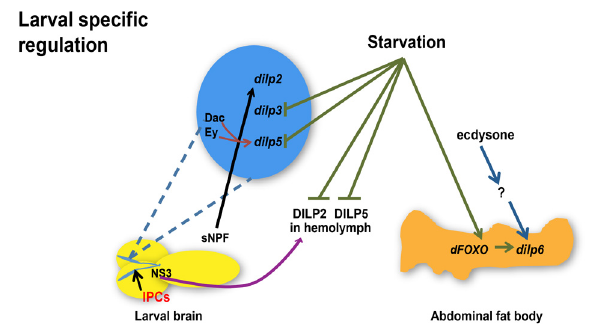
FIGURE 1 | Regulation of dilp expression and circulating DILP levels in response to nutrient status, transcriptional factors, hormone, and a neuropeptide during larval development. Starvation represses dilp3 and dilp5 expression and induces dilp6 expression through dFOXO in the abdominal fat body whereas circulating DILP2 and DILP5 levels in the hemolymph are diminished. Ecdysone regulates dilp6 during larval-pupal transition through unknown effectors. sNPF peptide secreted from sNPFnergic neurons located adjacent to IPCs increases dilp2 expression. NS3 in serotonergic neurons positively regulates DILP2 secretion. Transcriptional factors Dachshund (Dac) and Eyeless (Ey) synergistically promote the expression of dilp5 . dilps, genes encoding Drosophila insulin-like peptides; DILPs, Drosophila insulin-like peptides; IPCs, Insulin-like peptide producing cells; NS3, a nucleostemin family GTPase; sNPF, short neuropeptide F. Arrows indicate positive regulation whereas blunt-ended lines indicate negative regulation.